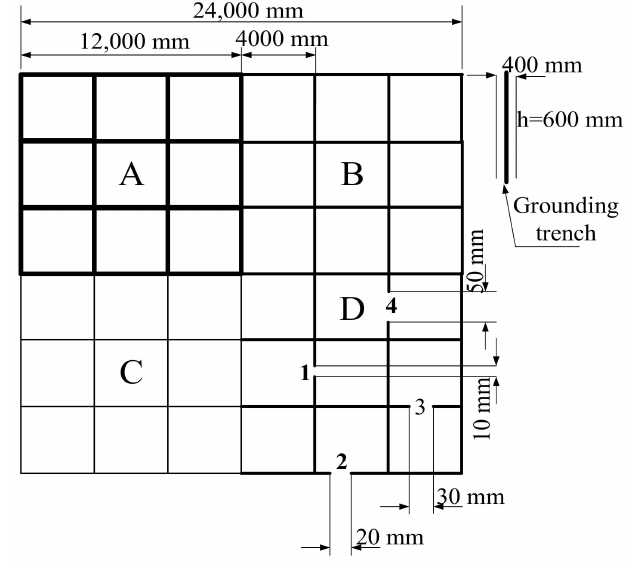
Figure 3. Wuhan Nanrui grounding grid experimental